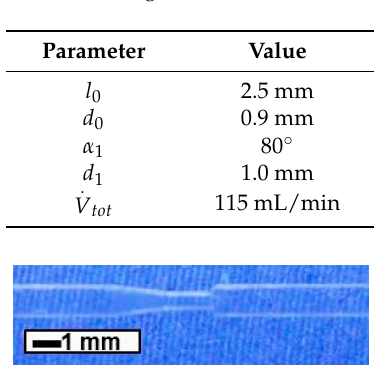
Figure 21. Manufactured micronozzle with optimal parameter settings. Table 5. Optimum factor setting for efficient turbulent bubble breakup.